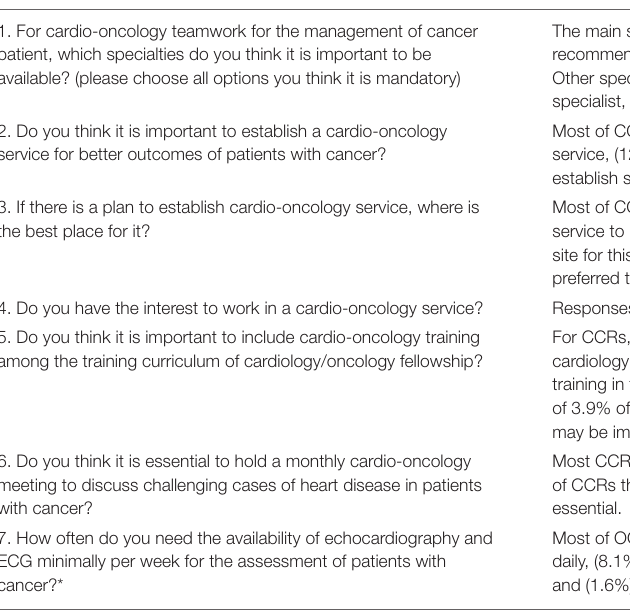
TABLE 3 | Questions about cardio-oncology service.